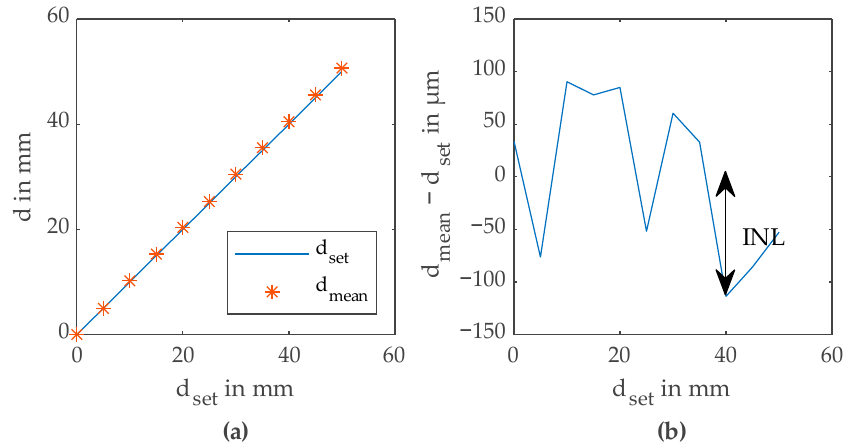
Figure 8. ( a ) Distance d set and averaged measured distance d mean over d set ; ( b ) measurement of INL .